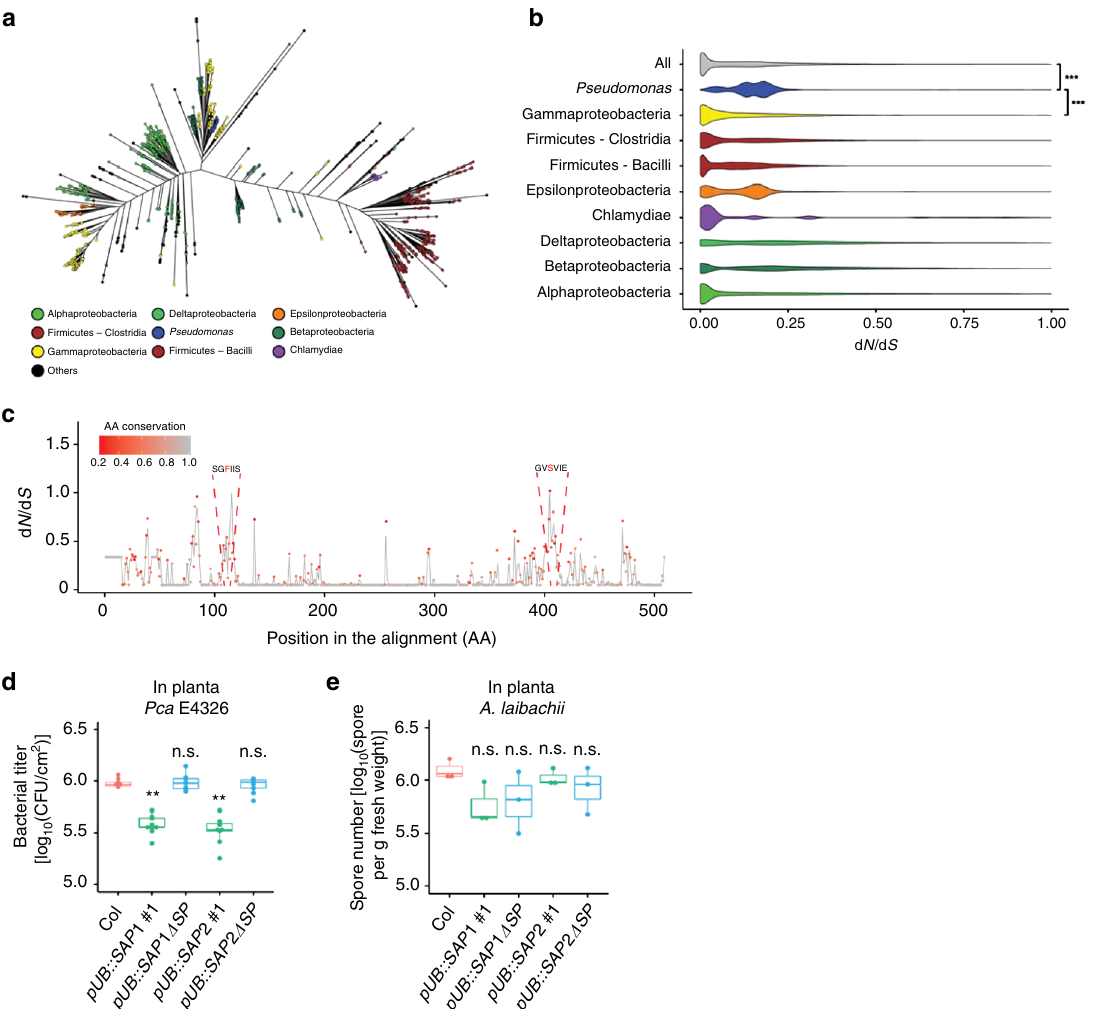
to that of the endogenous reference gene ACTIN2 . The used primers are listed in Supplementary Table 2.